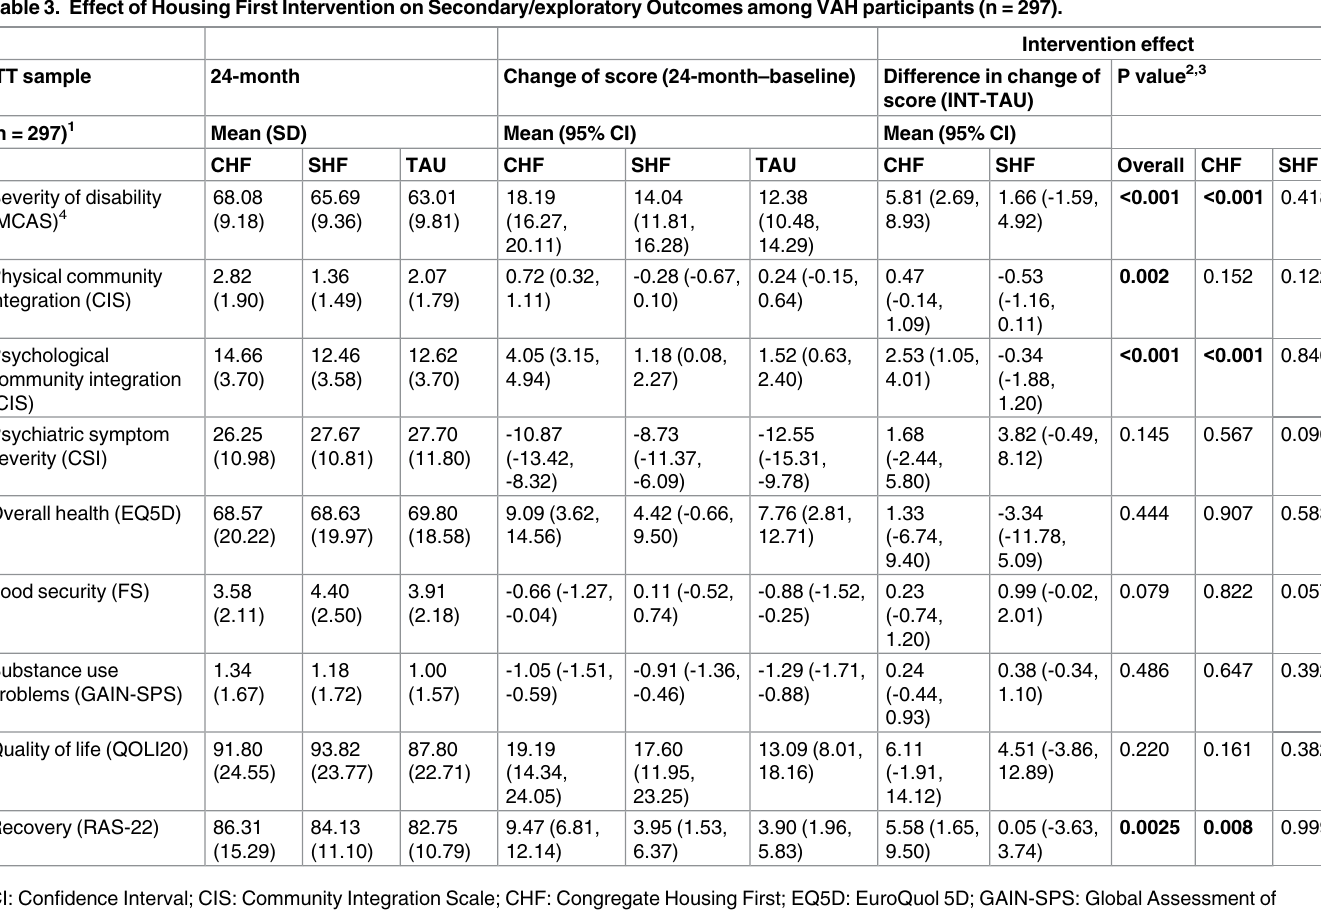
Table 3. Effect of Housing First Intervention on Secondary/exploratory Outcomes among VAH participants (n = 297).